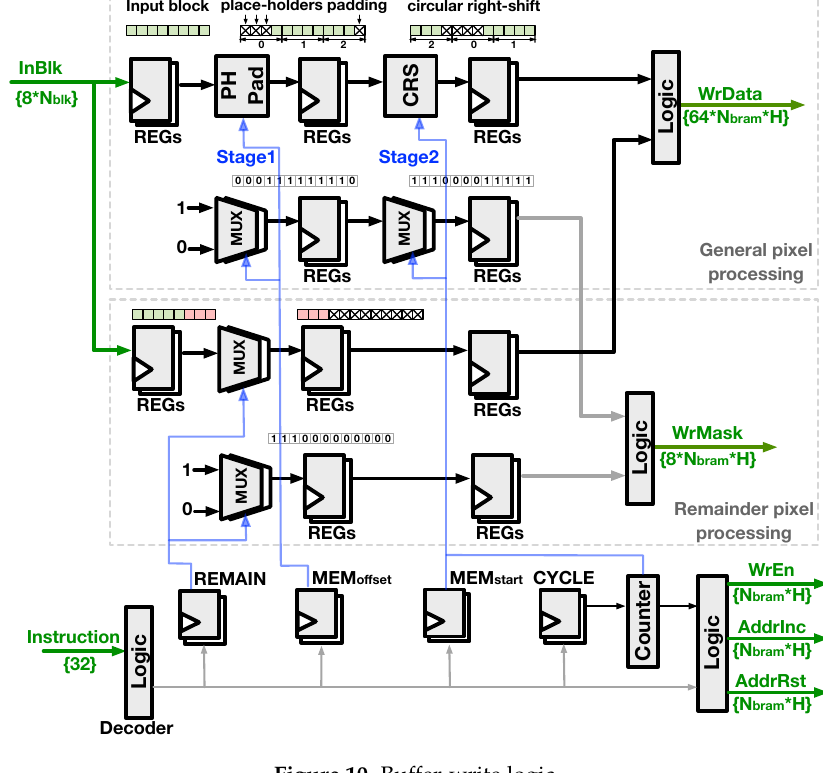
Figure 10. Buffer-write